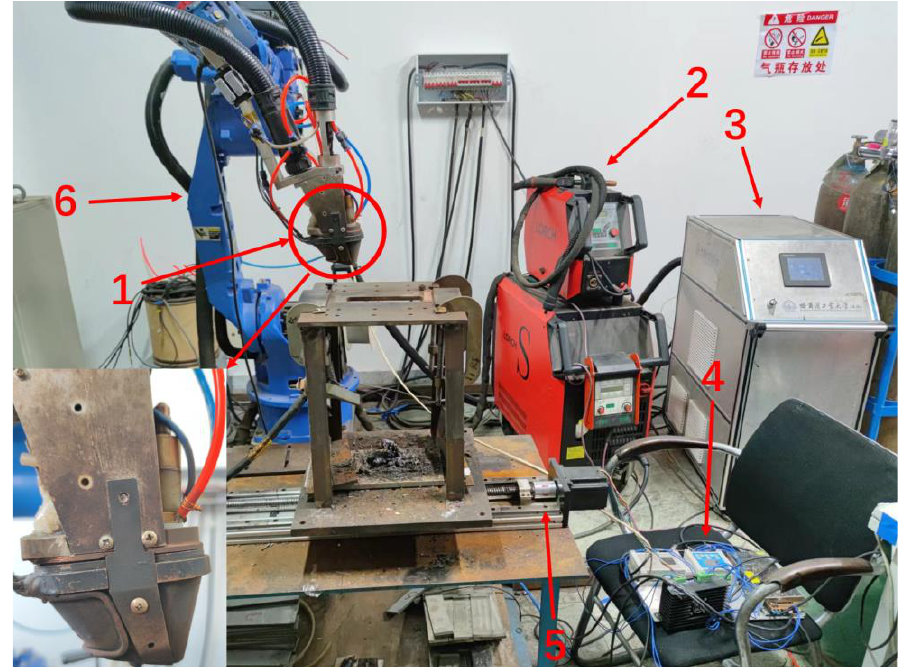
Figure 1. Welding system overall distribution physical diagram: 1 — Plasma-MIG hybrid torch; 2 — MIG power supply; 3 — PAW power supply; 4 — welding process control system; 5 — walking mechanism; 6 — welding robot.